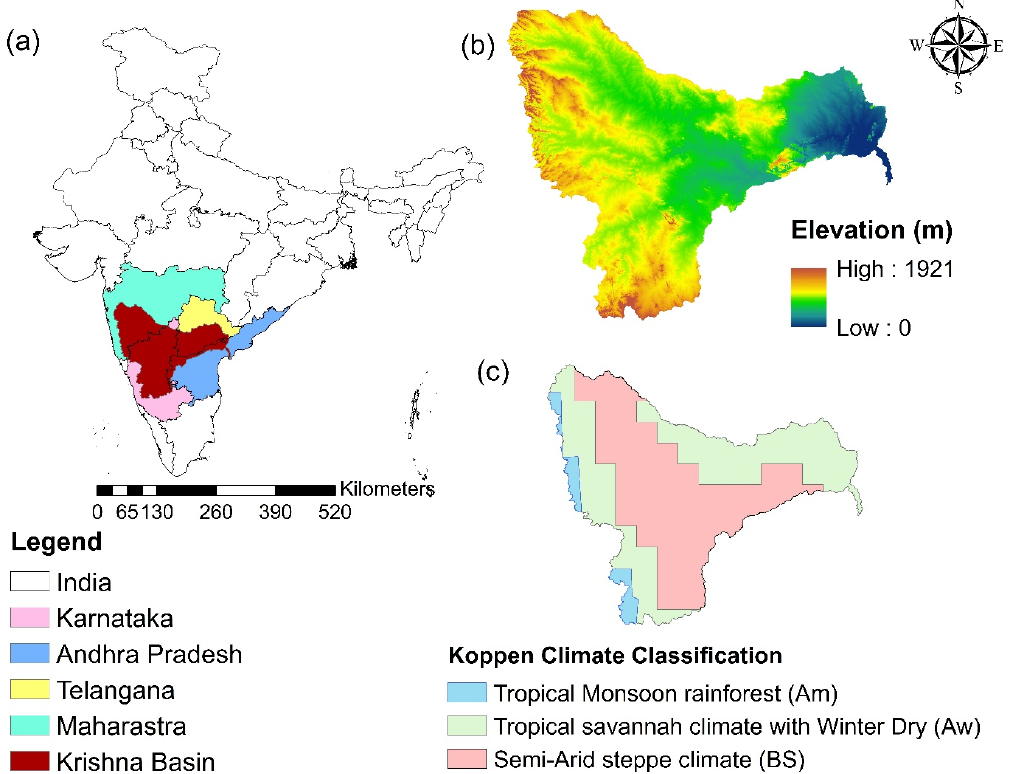
Figure 1. ( a ) Physiographic description of the study area; ( b ) Digital Elevation Model; ( c ) Koppen climatic classification.